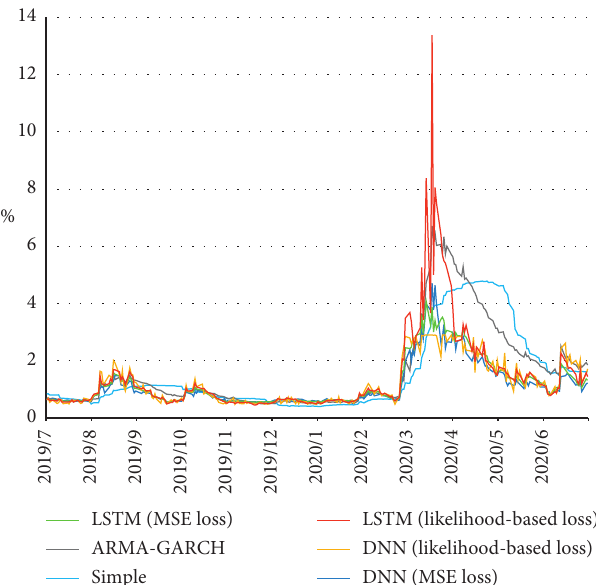
Figure 8: Volatilities of S&P 500 that the models forecast within the latest one